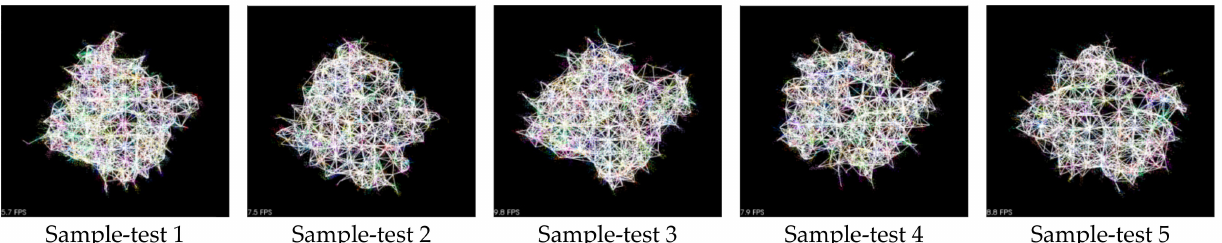
Figure 11. Supervoxel clustering results of random experiment group.